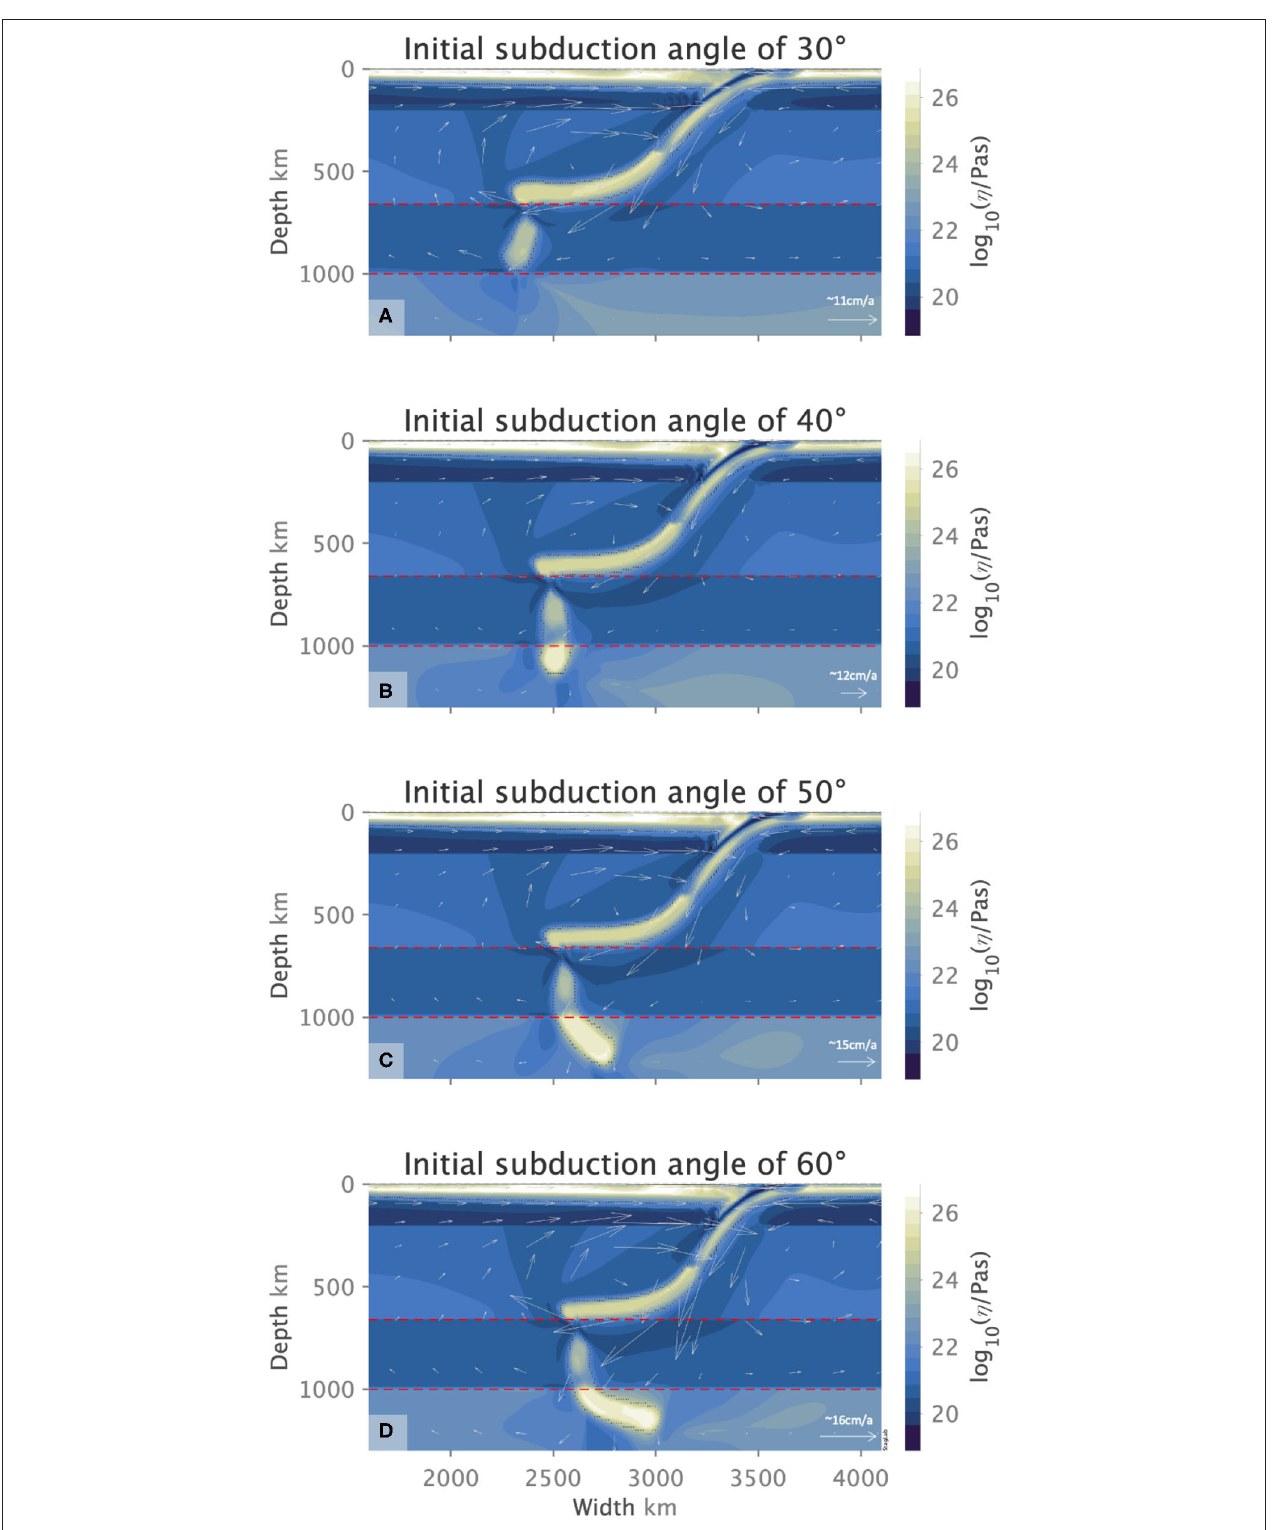
FIGURE 7 | Slab orphaning at 8.5 Myr for initial subduction angle of 30 ◦ (A) , at 9 Myr for 40 ◦ (B) , and 10 Myr for 50 ◦ and 60 ◦ (C,D) , respectively, in ocean-ocean settings. Flow arrows indicate the sense of flow direction and its relative magnitude for each figure.